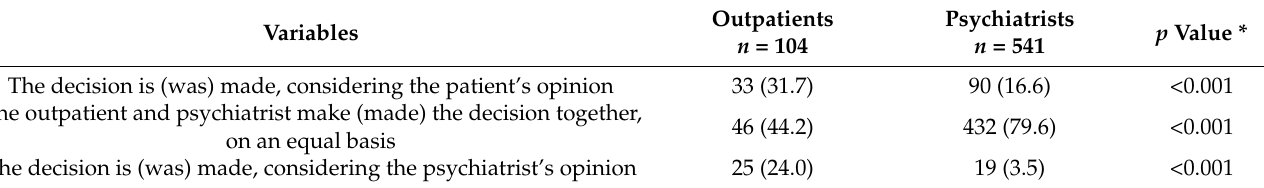
Table 4. Decision making regarding continuing/tapering hypnotic/anxiolytic